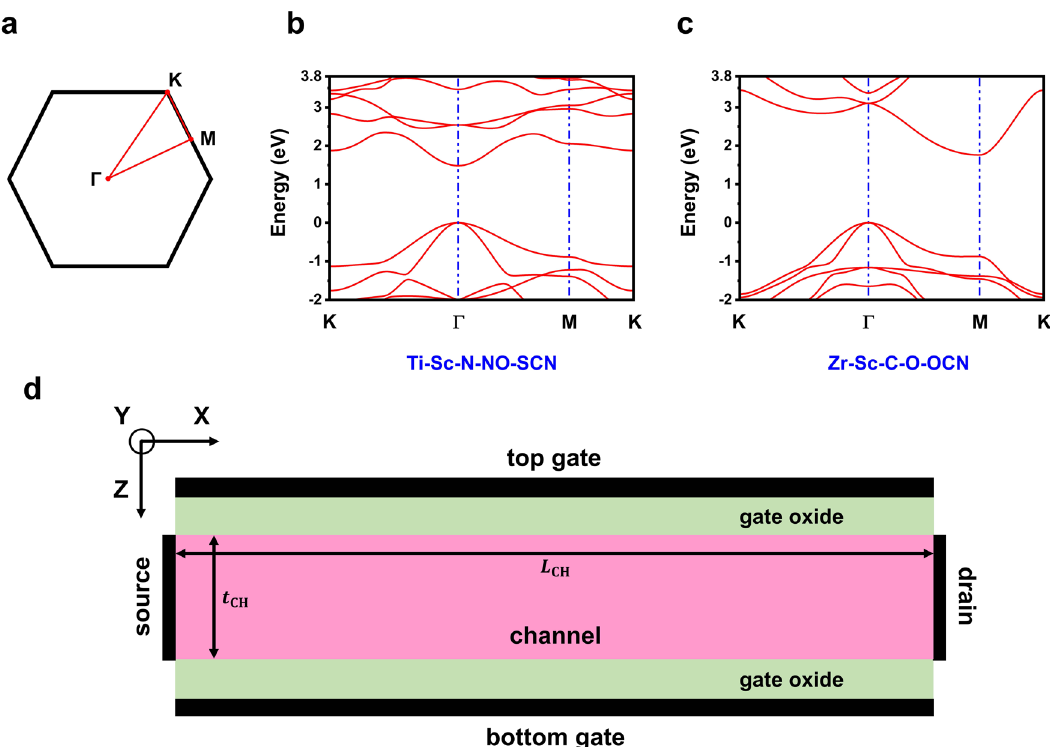
Fig. 4 Electronic properties and device schematic. a 2D hexagonal fi rst Brillouin Zone (BZ) of MXene semiconducting materials. Γ , M, and K are the high symmetry points of the BZ. b The HSE band structure of Ti-Sc-N-NO-SCN. VBM and CBM are located at Γ and exhibit isotropic dispersion. c The HSE band structure of Zr-Sc-C-O-OCN. VBM is located at Γ and has isotropic dispersion, while CBM is located at M, and the dispersion is anisotropic. d Schematic of the cross-sectional (x-z plane) view of the proposed SB